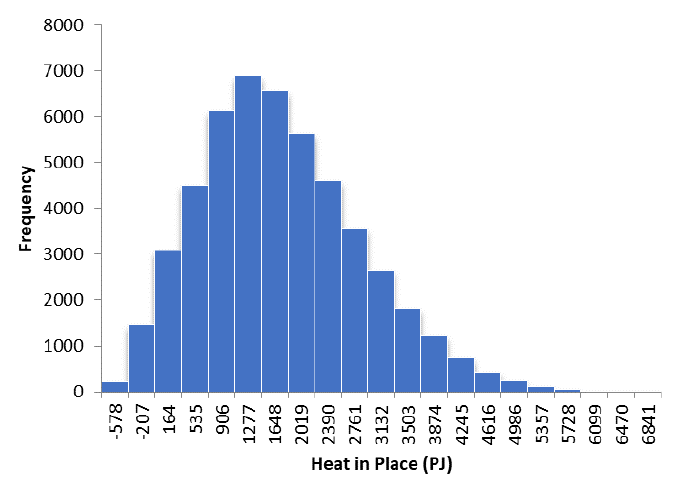
Figure 12. Heat-in-place probability distribution for well doublets—pre-rift phase. Distribution of the geothermal gradient by lithological units is shown in Figures 13–15.